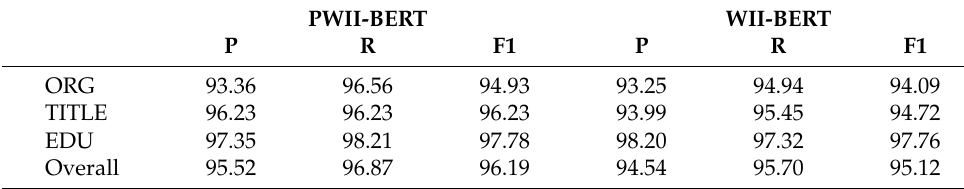
Table 5. Results of P, R, and F1 score on the Resume dataset.